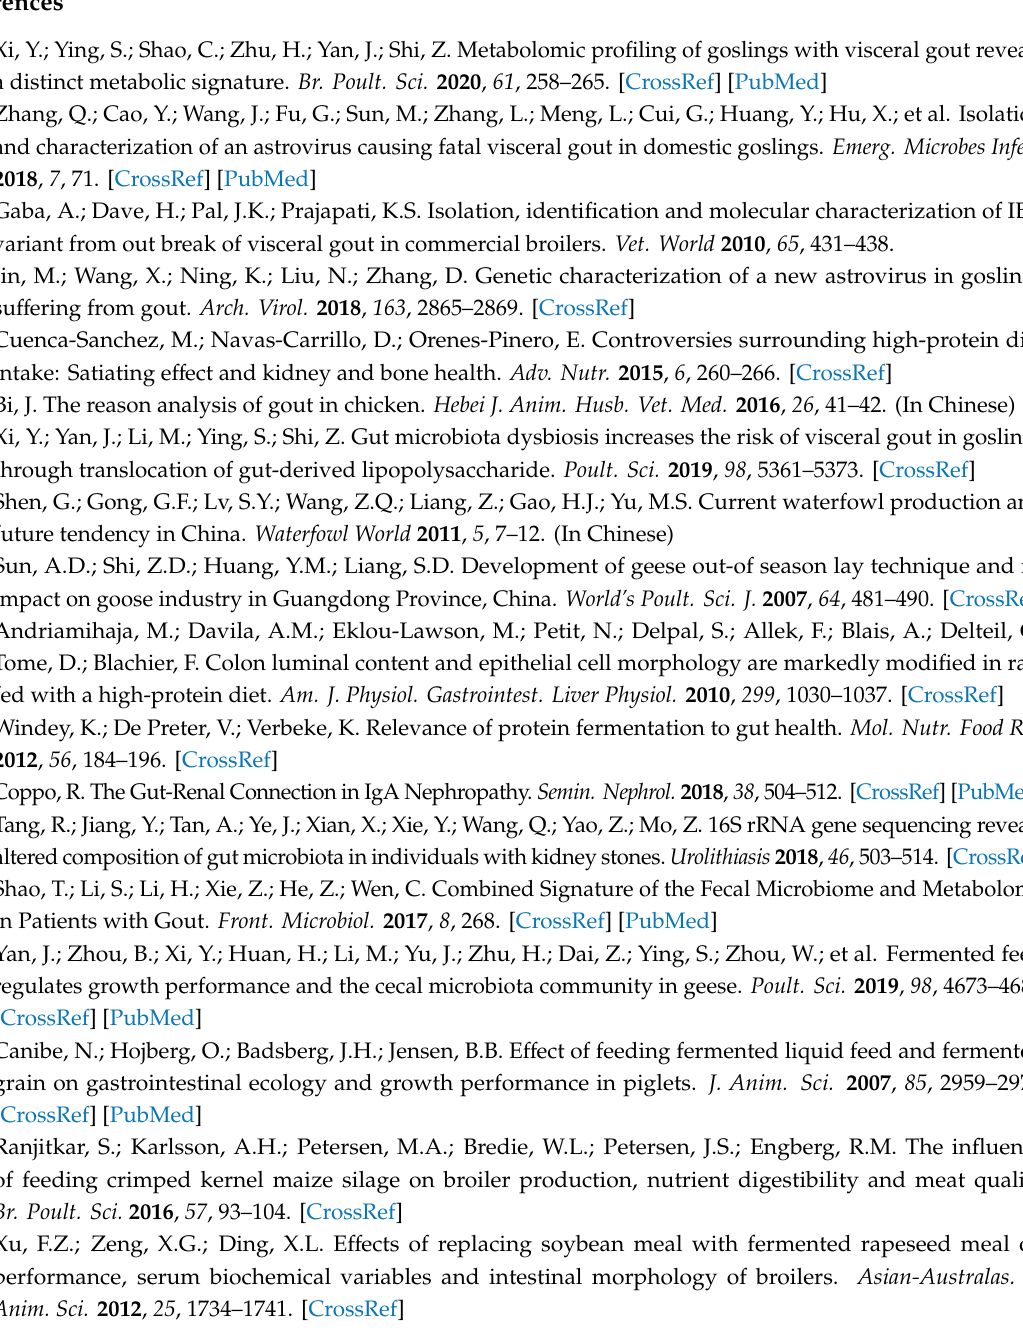
E ff ects of protein levels on Feed intake and BW in goslings ( Experiment one ), Table S2: E ff ects of high-protein diets and fermented feed on Feed intake and BW in goslings ( Experiment two